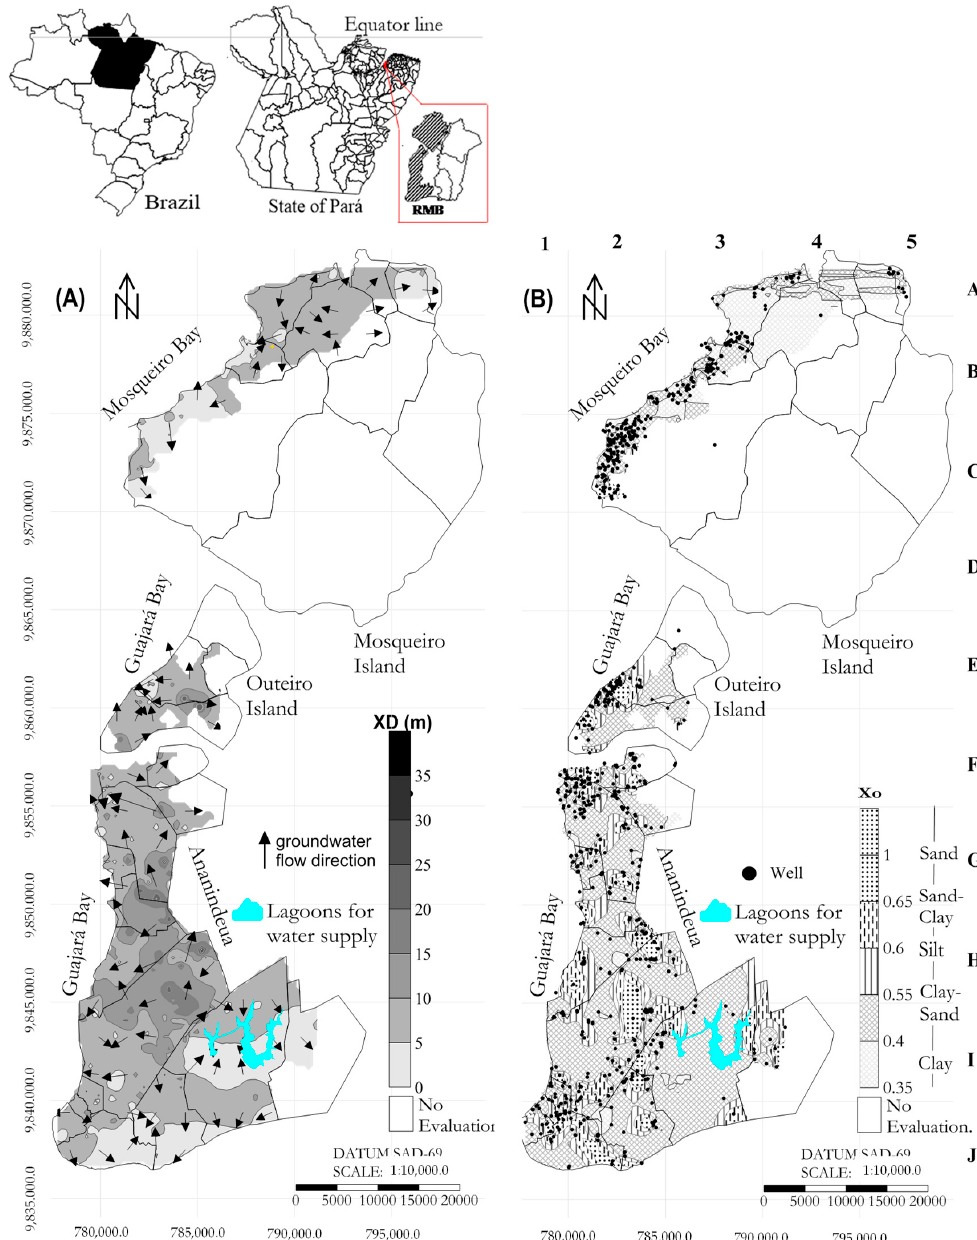
Figure 3. Spatial distribution of ( A ) depth to groundwater table ( x D ) (m); ( B ) overlaying strata ( x O ).